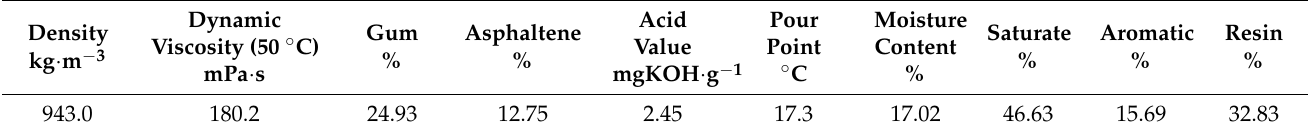
Table 1. Basic physical properties of crude oil produced from a block from Liaohe